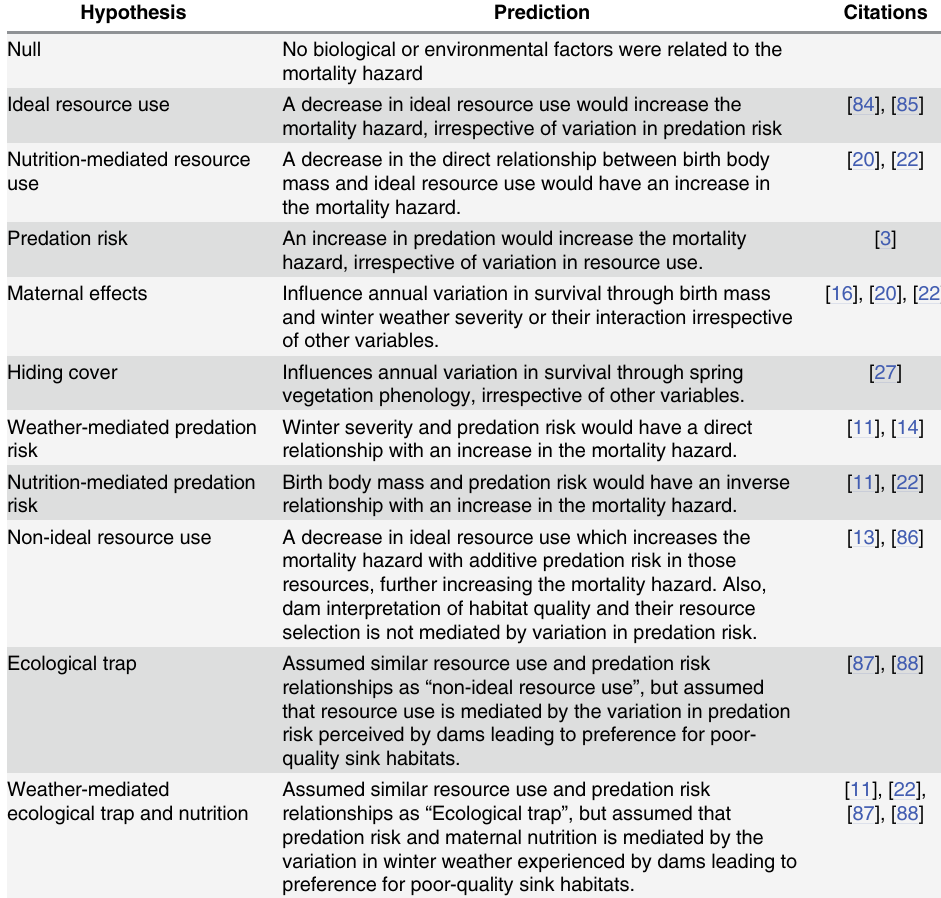
Table 1. Predictions used to assess daily or seasonal survival of neonate white-tailed deer ( (cid:1) 14 weeks of age) relative to resource use, predation risk, birth body mass, winter severity, and vegeta- tion hiding cover at the landscape scale in the southcentral Upper Peninsula of Michigan, USA, 2009 –